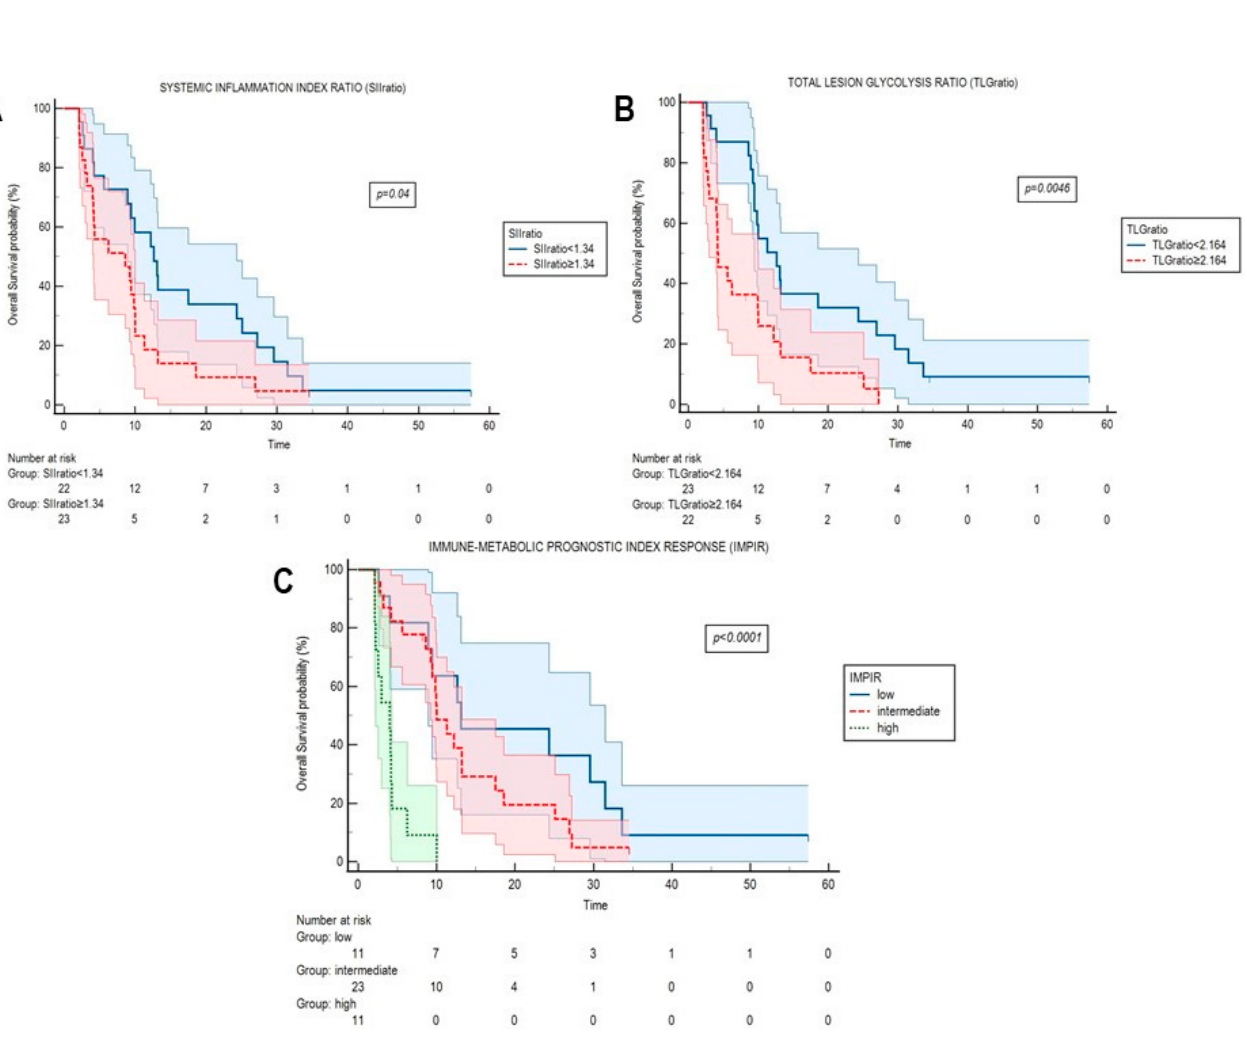
Figure 3. Kaplan–Meier curves for OS according to systemic inflammatory indexes, FDG-derived parameters, and their combination (IMPIR) in the evaluation of response. Kaplan–Meier curves for overall survival (OS) according to systemic inflammation index ratio (SIIratio, ( A )), total lesion glycolysis ratio (TLG, ( B )), and their combination in the immune- metabolic prognostic index response (IMPIR, ( C )). SIIratio, TLGratio, and IMPIR were calculated at the time of radiological progression with respect to baseline. Table 4. IMPI and IMPIR are independent predictors of OS.